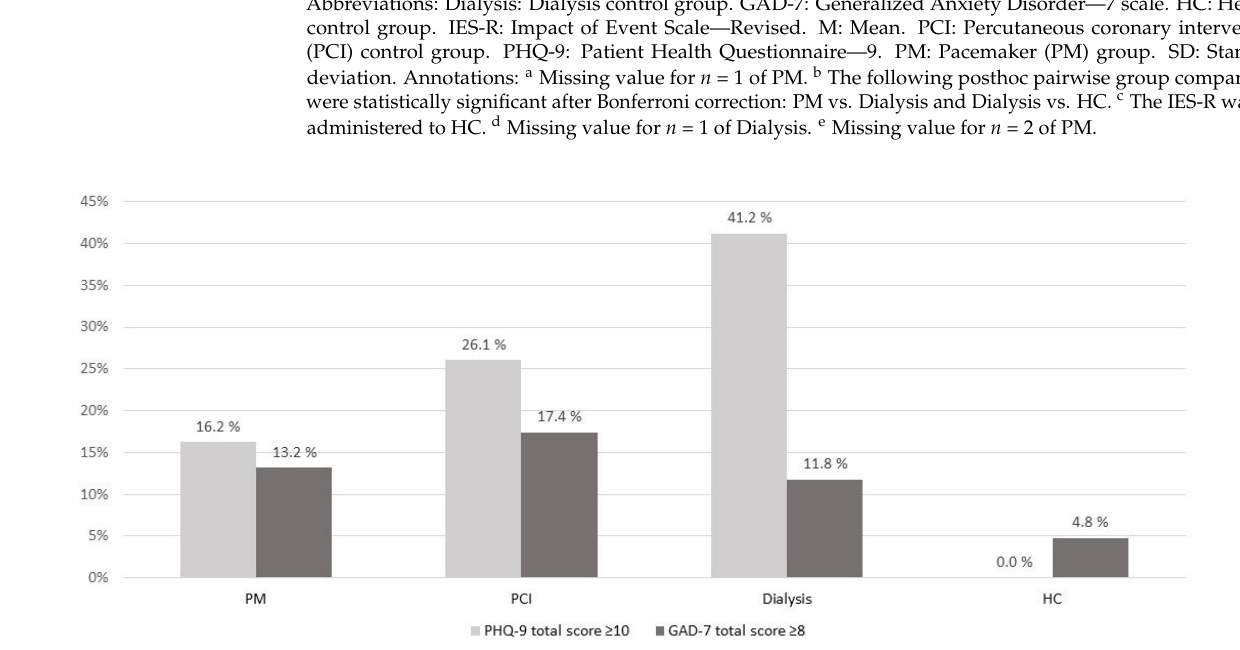
Table 2. Self-report of symptoms of depression, anxiety, and posttraumatic stress (measured by PHQ-9, GAD-7 and IES-R, respectively) according to study group.